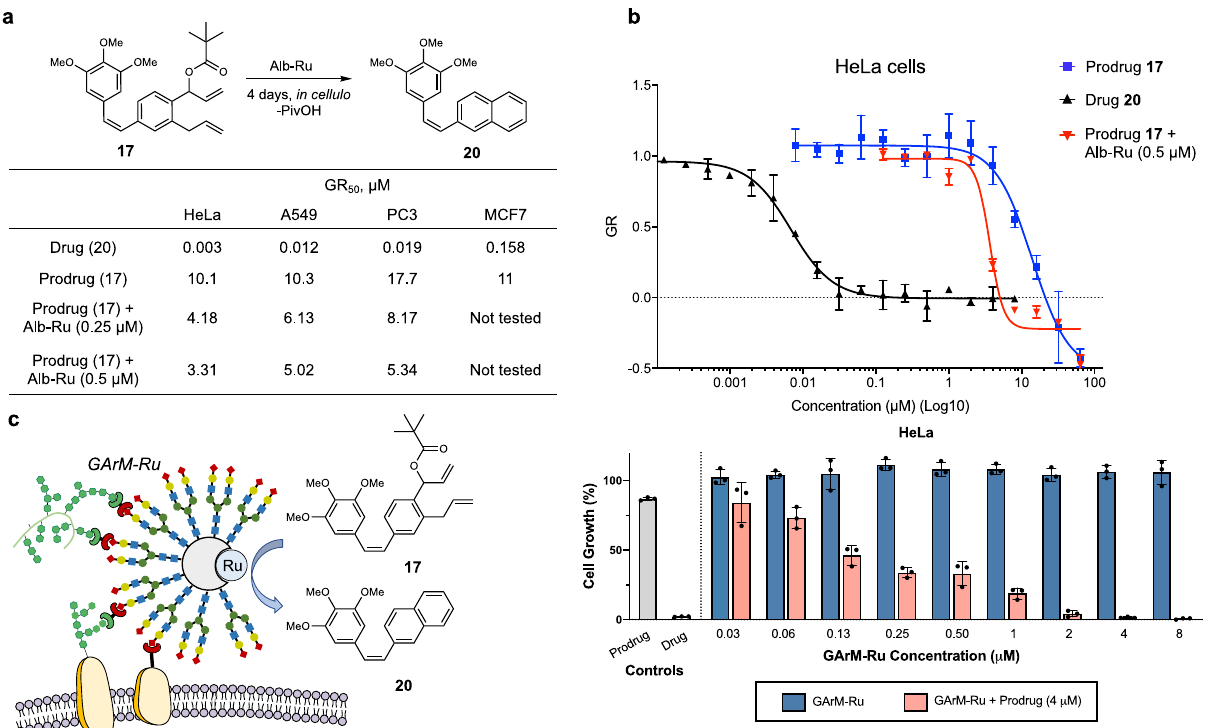
Fig. 5 In cellulo prodrug therapy against cancer cell growth. a Summary of calculated GR 50 values for drug 20 , prodrug 17 and prodrug/Alb-Ru mixtures against HeLa, A549, PC3 and MCF7 cell lines. GR 50 values represent concentrations that gives half maximal growth rate inhibition. b Representative dose response curves against HeLa cells showing the cytostatic activities of drug 20 , prodrug 17 , and mixtures of Alb-Ru (0.5 μ M) with prodrug 17 . c Schematic depiction of HeLa targeted activation of prodrug 17 into drug 20 using GArM-Ru. The inhibition of HeLa cell growth was investigated using varying mixtures of GArM-Ru and prodrug 17 . In general, the prodrug (and drug) was kept at constant concentrations of 4 μ M, while varying concentrations of GArM-Ru was used. Data in ( b ) and ( c ) are represented as mean values ± SD, n = 3 biologically independent